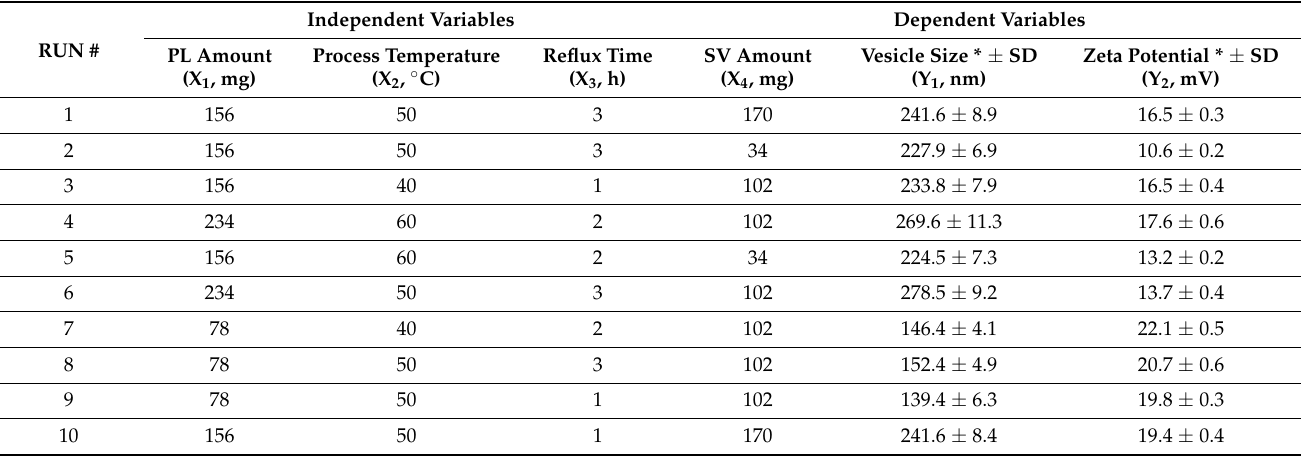
Table 2. Combination of variable levels in QRT-PHM-SV experimental runs and their corresponding measured